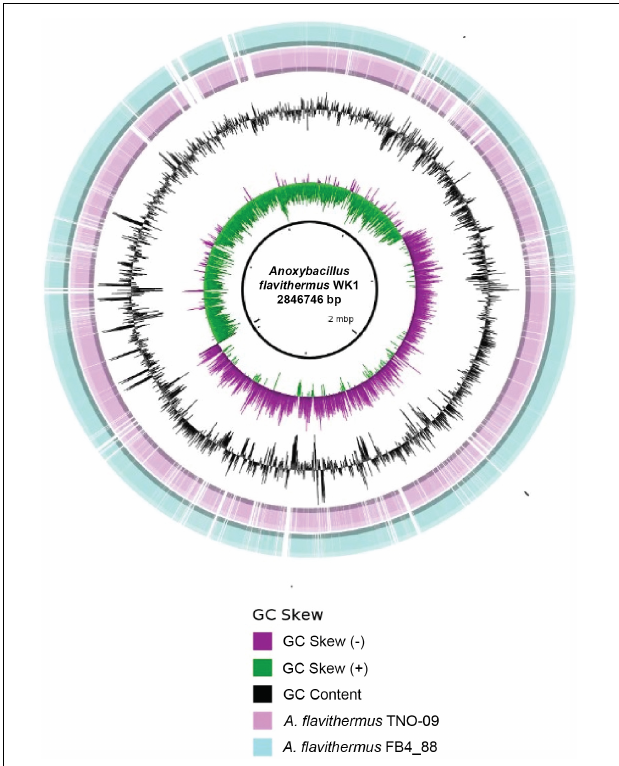
FIGURE 5 | Genome comparison of Anoxybacillus species. BRIG image with the genome sequence of strain WK1 set as the central reference, while other genomes (strains TNO-09 and FB4_88 isolated in this study) were set as concentric rings. The inner black circle comprises the complete reference genome; the intensity of each color indicates the degree of similarity of that strain to the reference